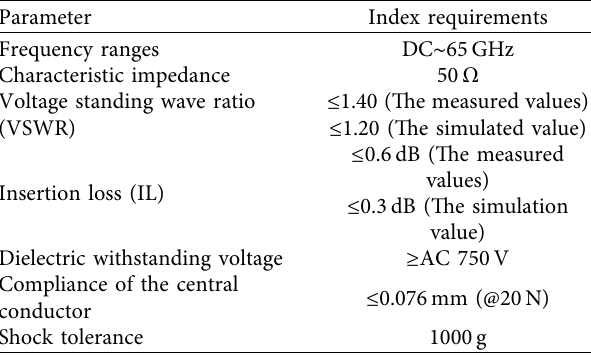
Table 1: Design requirements of the 65GHz RF connector.